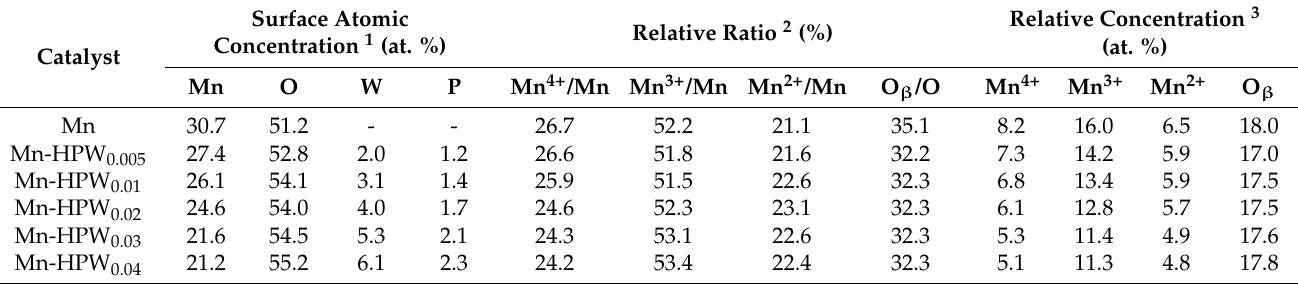
Table 2. Atomic surface concentrations on Mn and Mn-HPW x